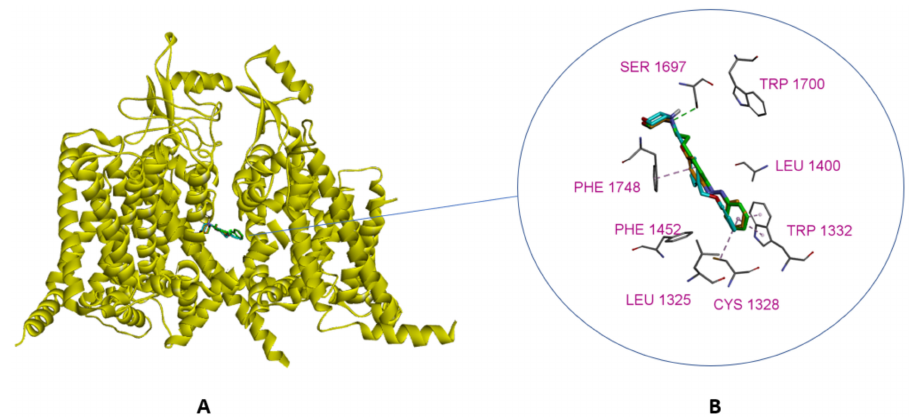
Figure 4. ( A ) Structure of the Na v 1.7 channel (PDB ID: 6J8H) with docked structures of fotocaine, ethercaine, and fomocaine (shown in green, orange, and cyan, respectively). ( B ) Ligand interactions with the binding site of the Na v 1.7